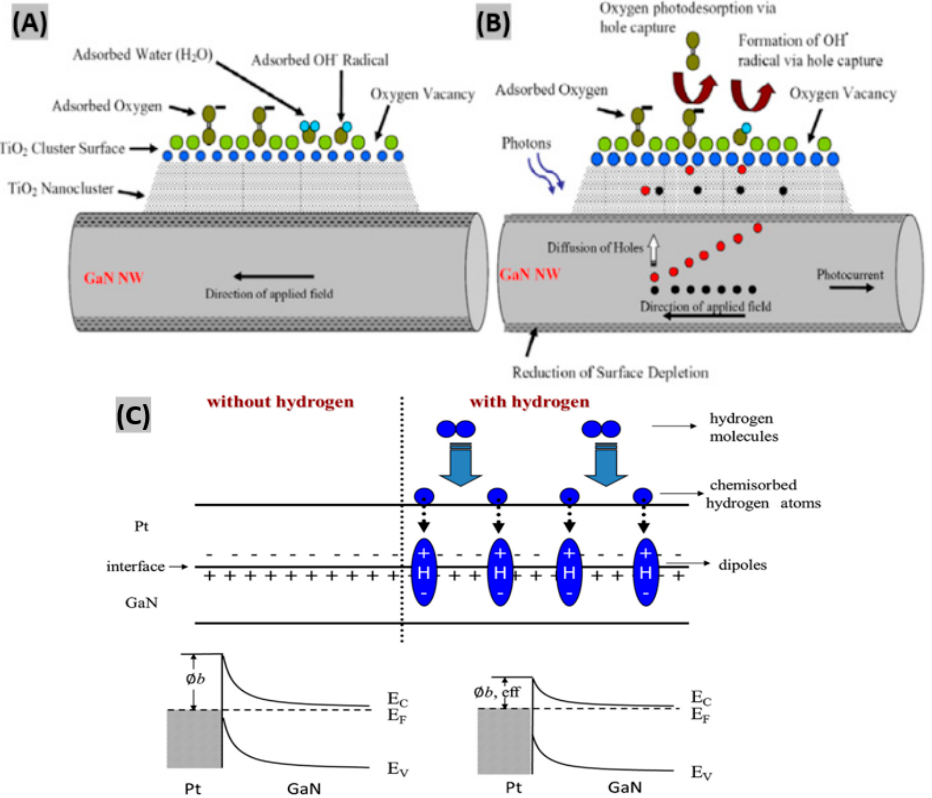
Figure 9. Gas sensing mechanism illustration using schematic representation of the GaN/TiO 2 sensor ( A ) in the dark, and ( B ) under UV illumination. Figures adapted with permission from [55], Copyright 2011 IOP Publishing Ltd. ( C ) Sensing mechanism of H 2 gas on GaN/Pt sensor device. Figure adapted with permission from [42], Copyright 2014 Hydrogen Energy Publications, LLC. Published by Elsevier Ltd.